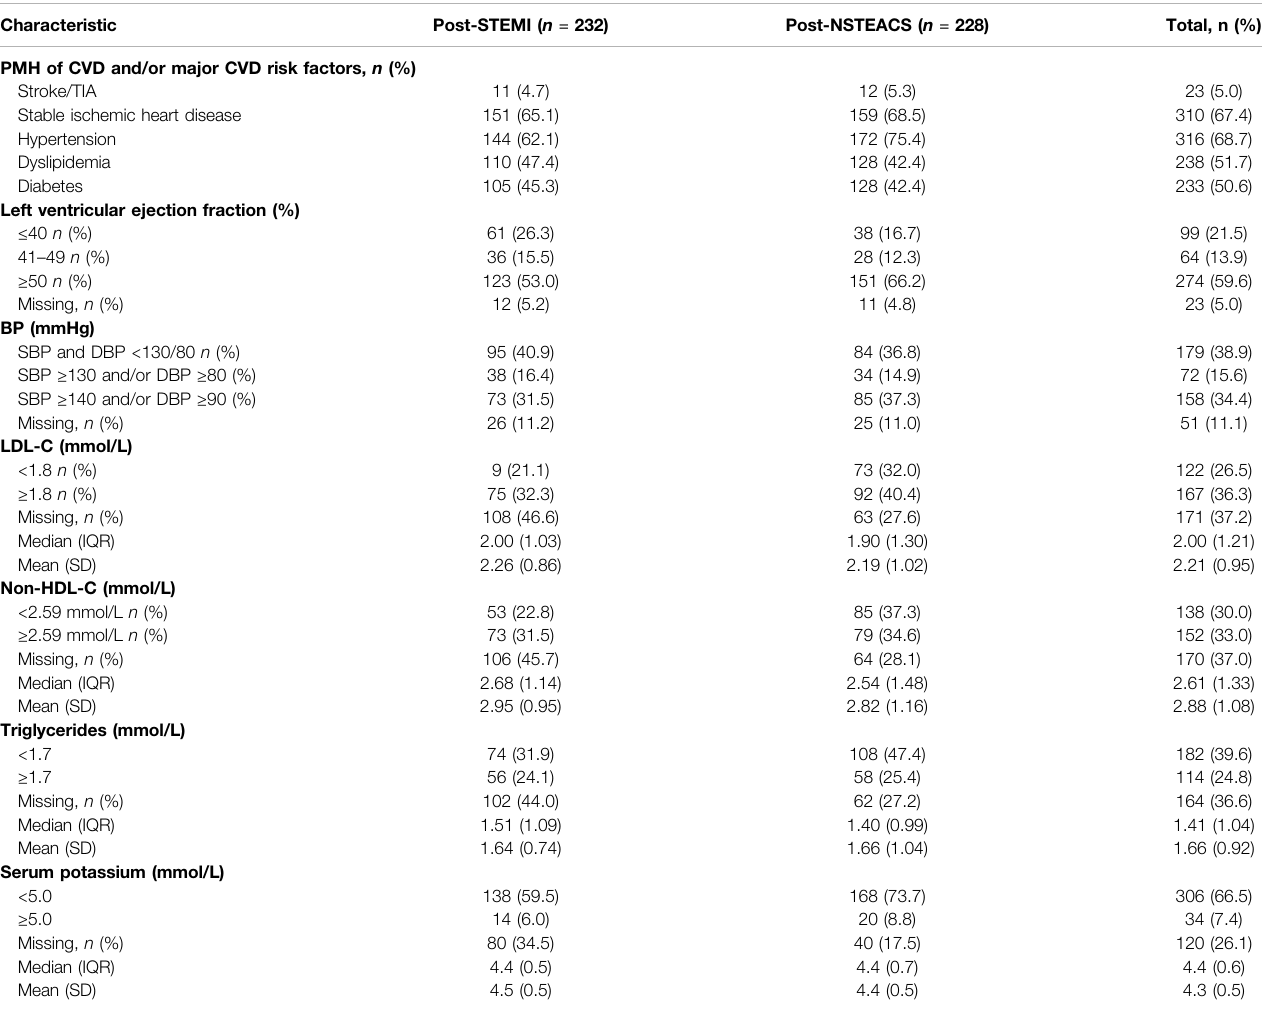
TABLE 4 | Clinical characteristics of patients ( n (cid:1) 460).